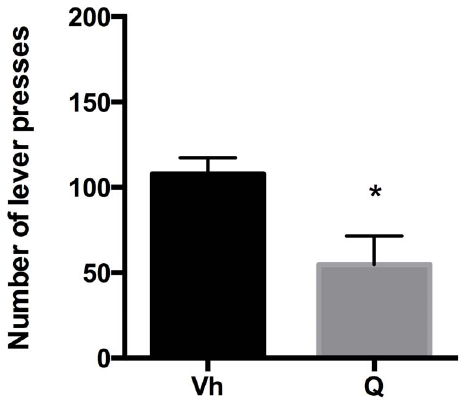
Figure 2. Quinpirole and Extinction. Number of lever presses during the 20-min Extinction session, in vehicle (Vh) - and quinpirole (Q) treated rats. *p , 0.05 Vs Vh.